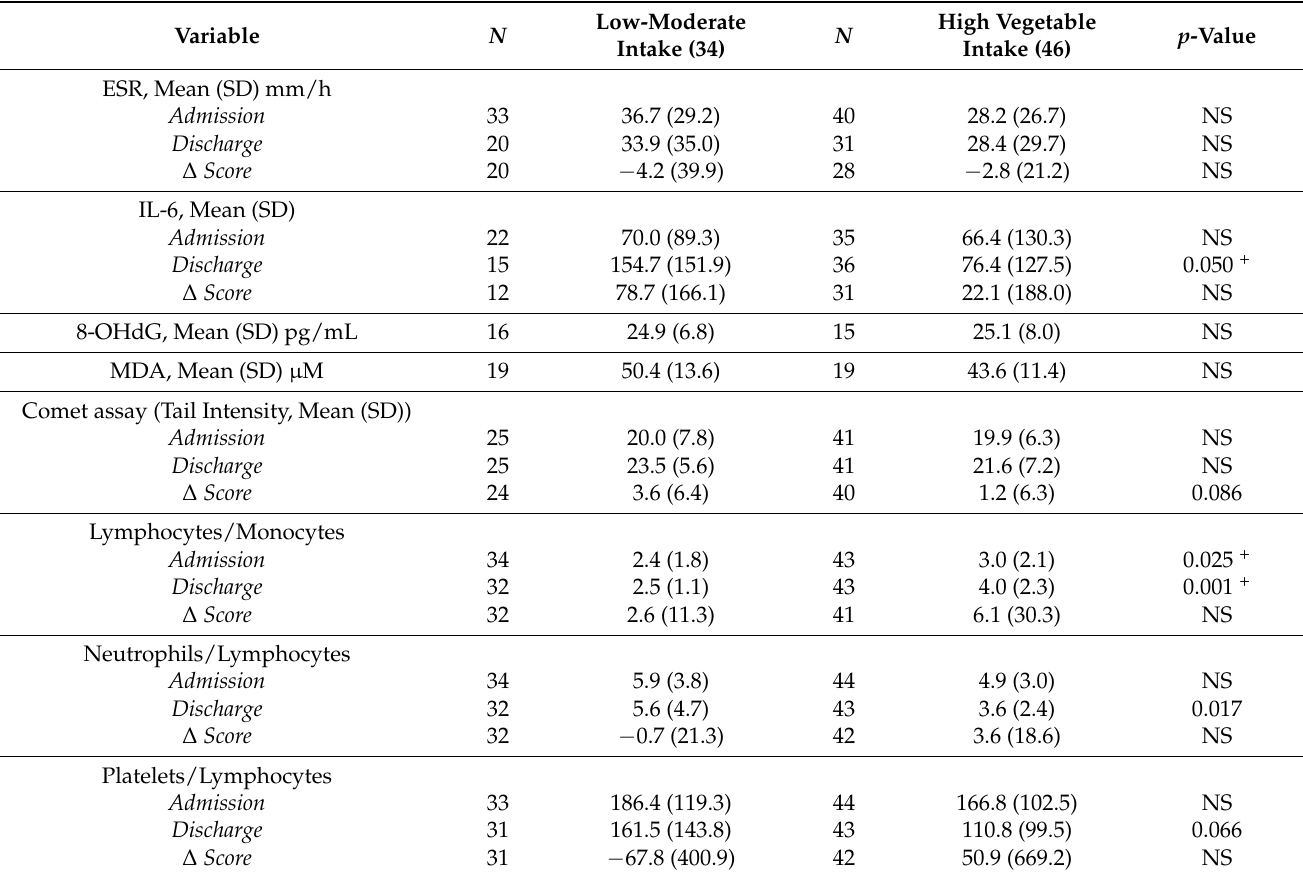
Table 4. Biomarkers of oxidative stress, inflammation and DNA damage in COPD patients by daily vegetables intake. Variable N